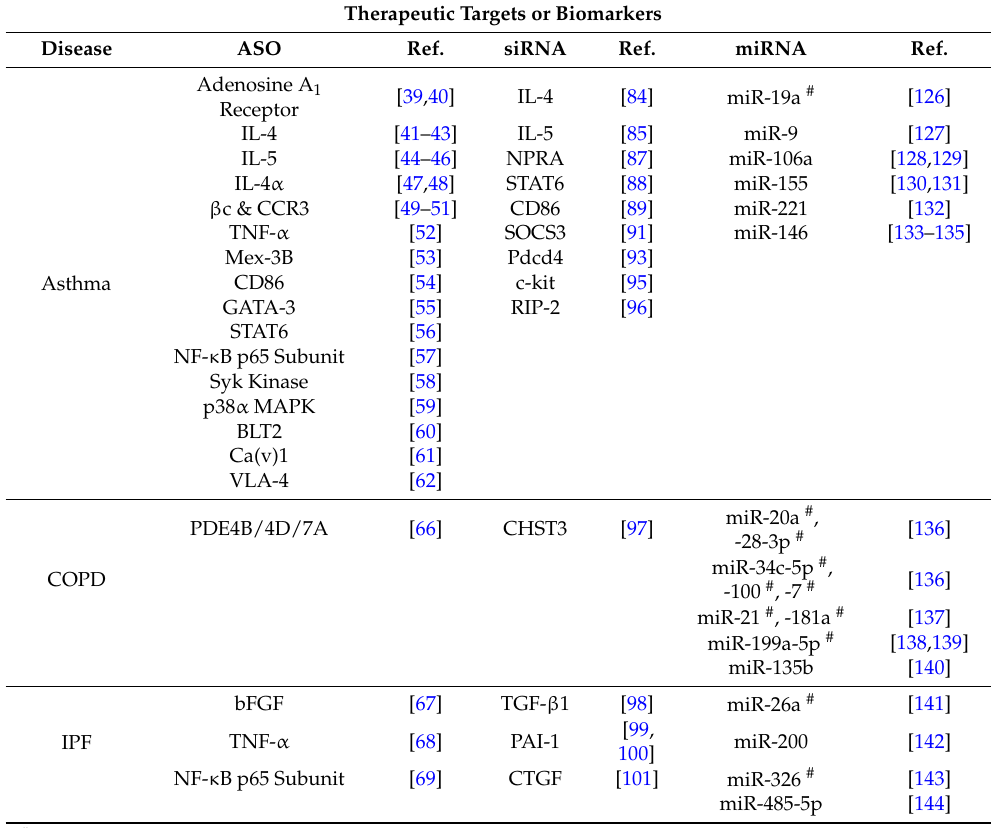
Table 2. Oligonucleotide therapeutic targets or biomarkers for asthma, COPD, and pulmonary fibrosis. Therapeutic Targets or Biomarkers Disease ASO Ref. siRNA Ref.